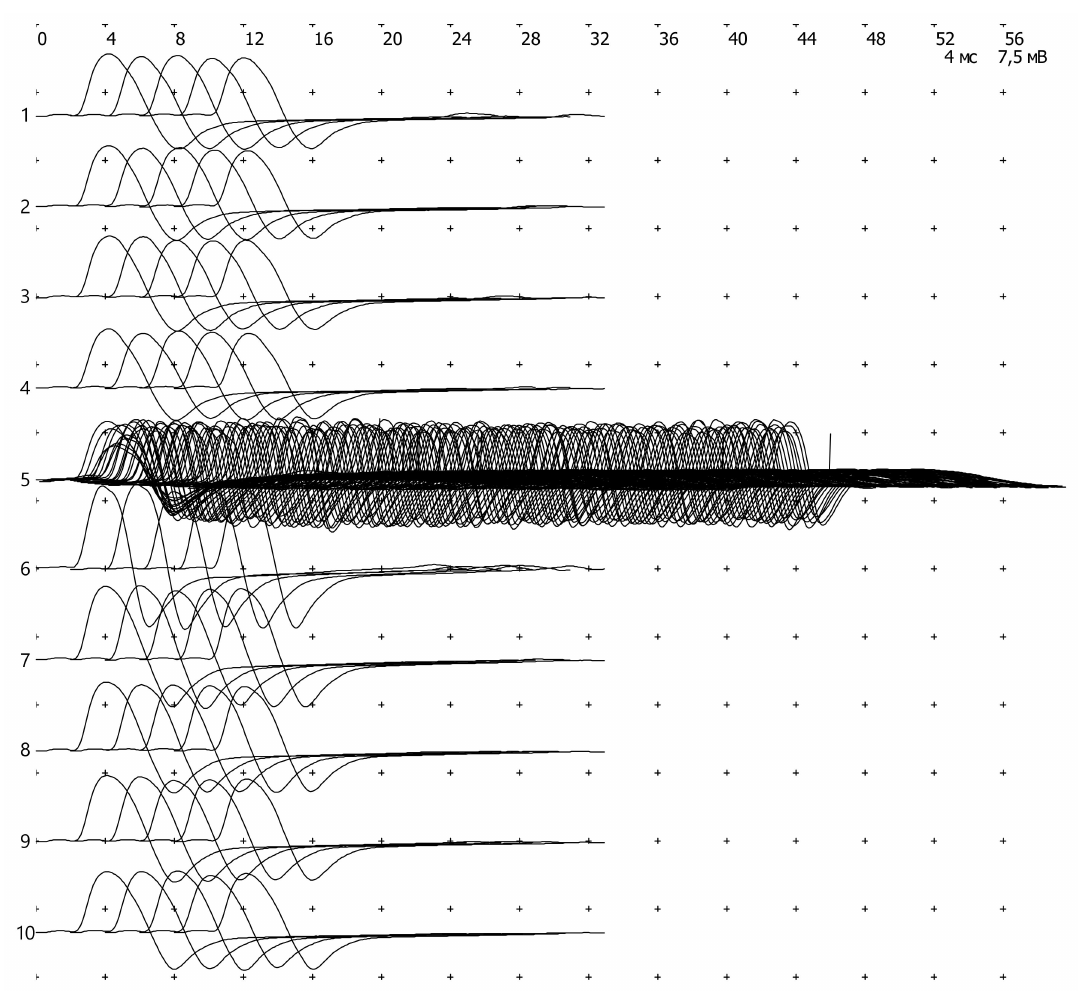
Figure 3. Test of rhythmic stimulation with tetanization (m. adductor pollicis ulnaris sin, C8 T1, 20 mA, duration—200 µ s).